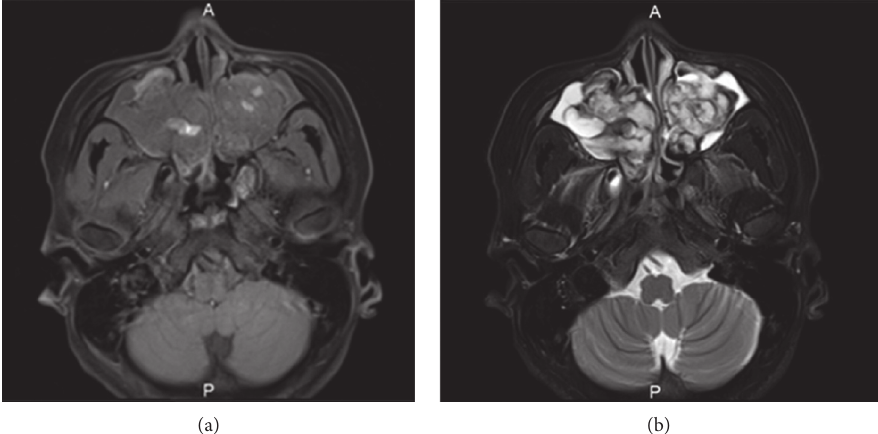
Figure 2: Magnetic resonance imaging (MRI). The mass as heterogeneous signal intensity arises from the bilateral maxillary sinus and extend to the nasal cavity on (a) T1-weighted image and (b) T2-weighted